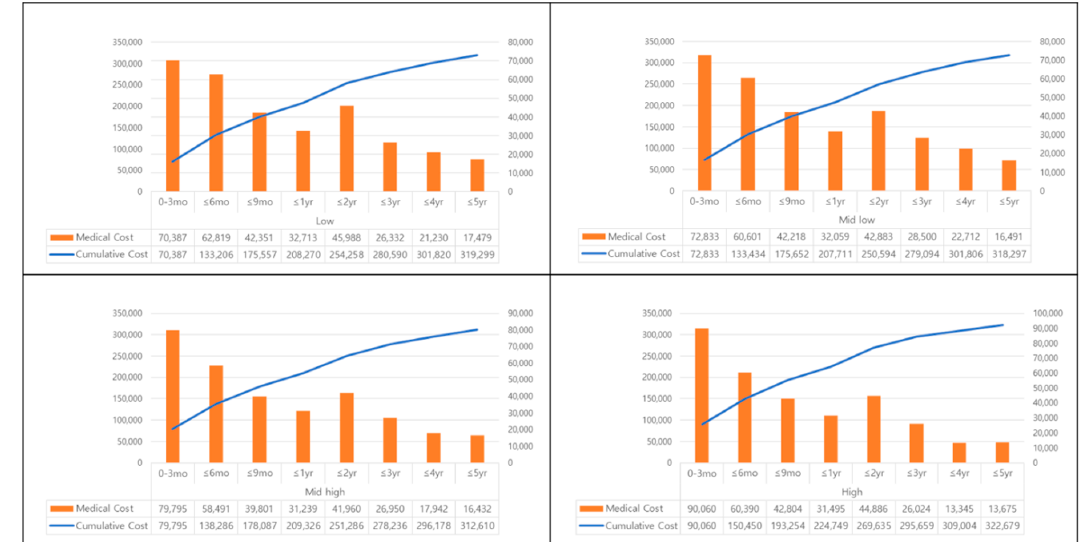
Figure 1. Medical costs of childhood cancer survivor by socioeconomic status in each treatment phase cost and cumulative cost † . † Presented in KRW (Approx. KRW 1140.40 = USD 1 on average, year 2015).